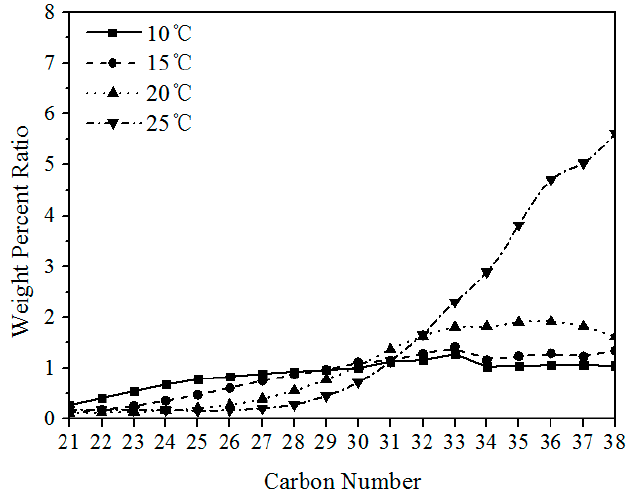
Figure 12. The weight percent ratio of each carbon number in precipitated wax at different temperatures of 15% artificial oil.